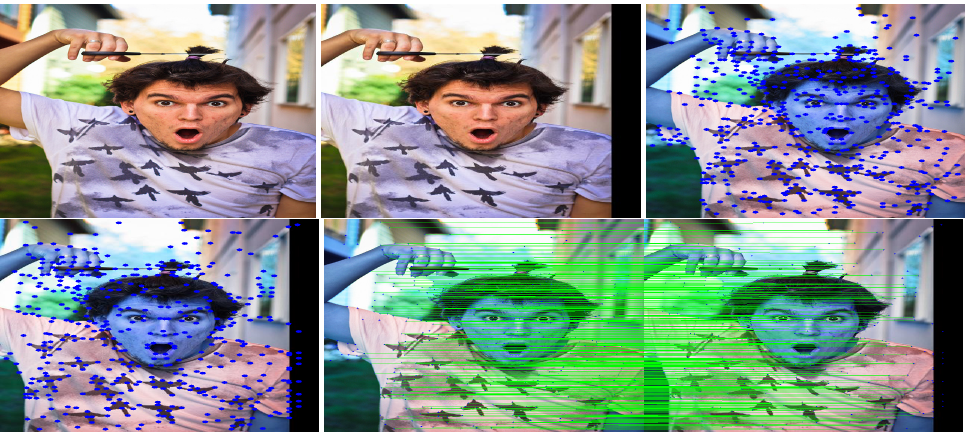
Figure 13. ( Lens ) Row 1: Left (original image), Middle (attacked images.), Right (resulting point of original image by SuperPoint’s detector). Row 2: Left (resulting point of attacked image by SuperPoint’s detector), Right (the green lines show the correct correspondences after blurring